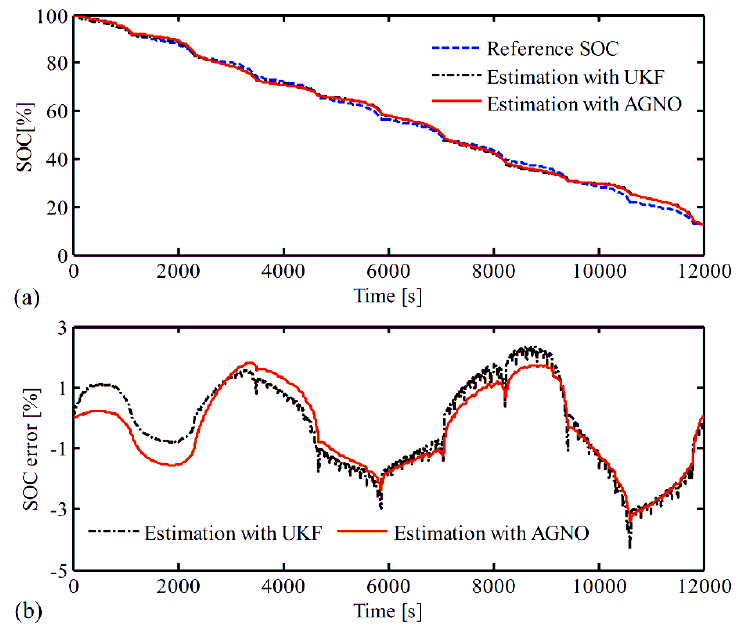
Figure 7. Comparison of SOC estimation under NEDC test: ( a ) SOC ; and ( b ) SOC error. UKF: unscented Kalman filter; and AGNO: adaptive gain nonlinear